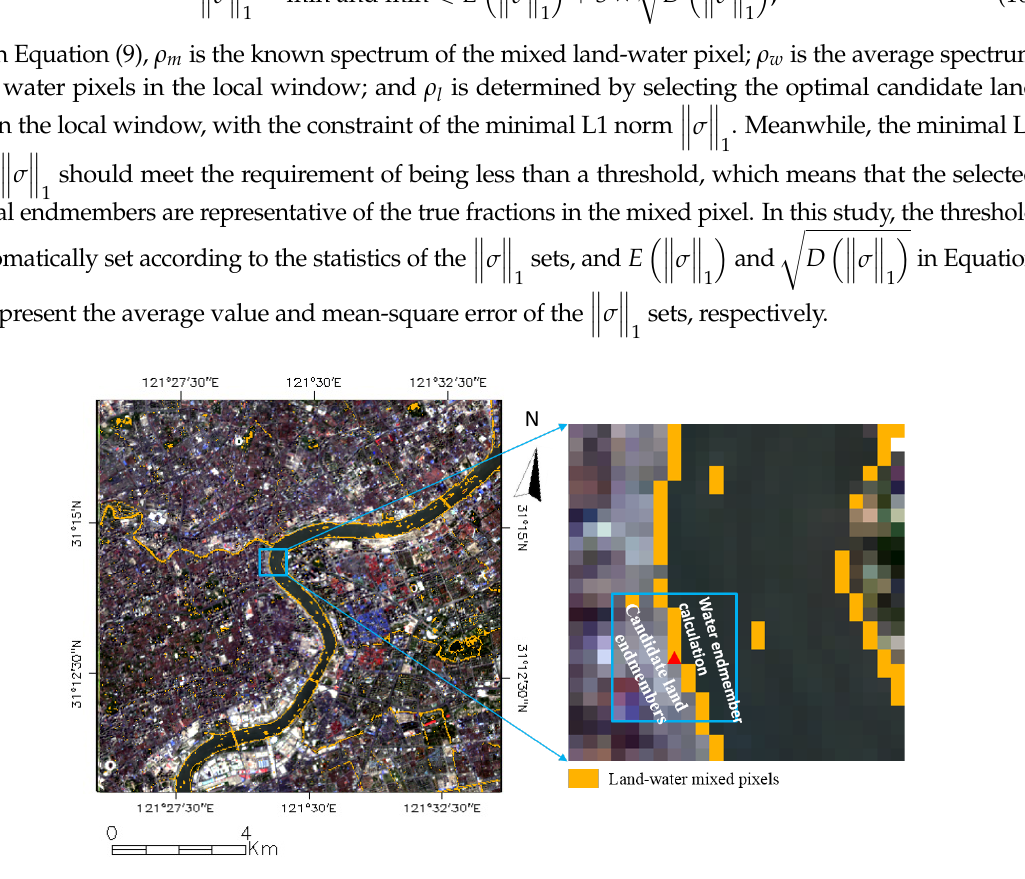
Figure 5. Endmember determination based on adjacent pixels (Landsat OLI true-color composite (RGB: bands 4, 3,